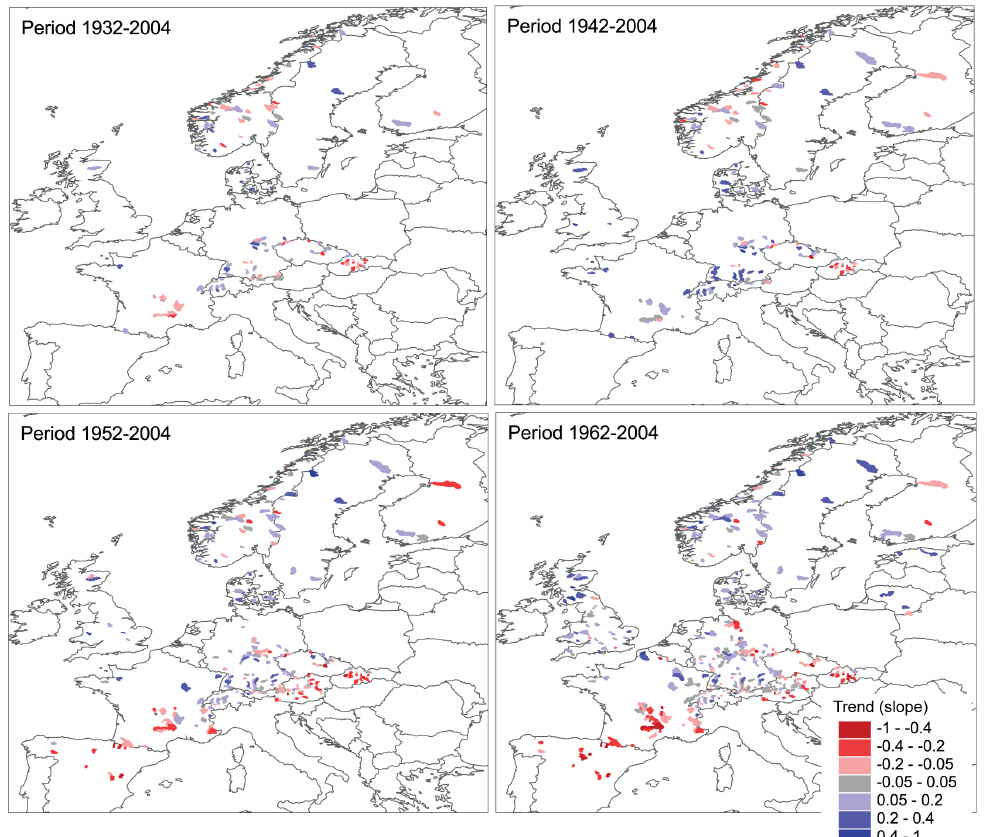
Fig. 1. Trends in annual streamflow for four different periods (trends are given in standard deviations per